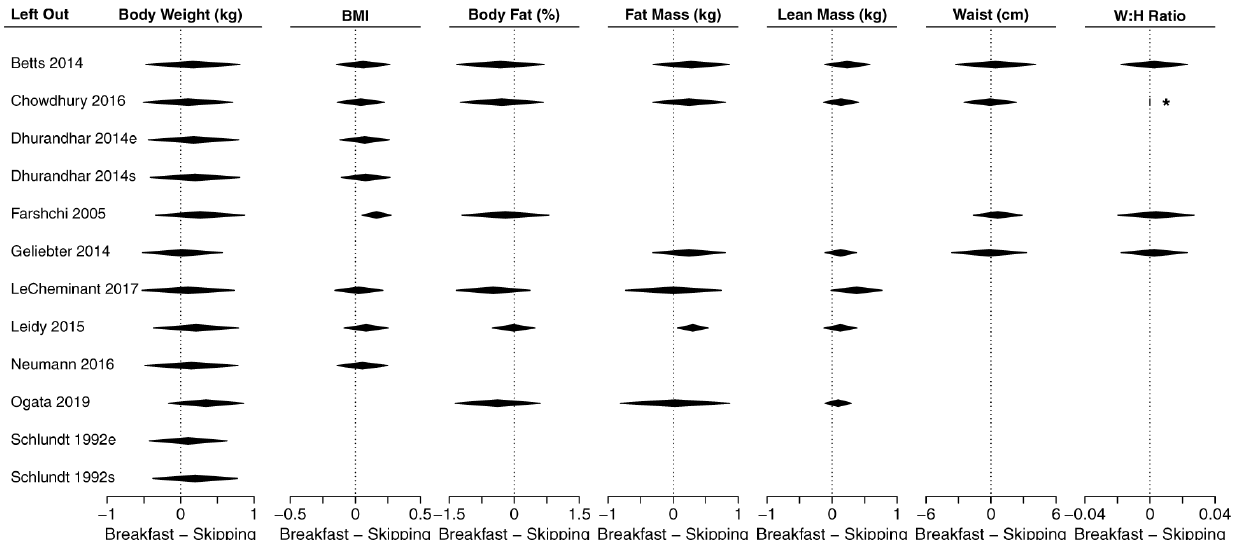
Figure 5. Leave-one-out analysis. Within each column, the diamond represents the meta-analytic summary estimate when leaving out the study in a particular row. Row and column combinations without diamonds represent outcomes that are not reported for that particular study. *The waist:hip ratio had no estimable confidence interval because the three remaining estimates were all 0.00. Sagittal abdominal diameter and fat mass index were only included in the two papers from the Bath Breakfast Project (Betts et al. and Chowdhury et al. ), and therefore a leave-one-out analysis would include only a single study; outcomes of muscle mass and total body water percent were only included in Ogata et al. , and so a leave-one-out analysis is not possible.